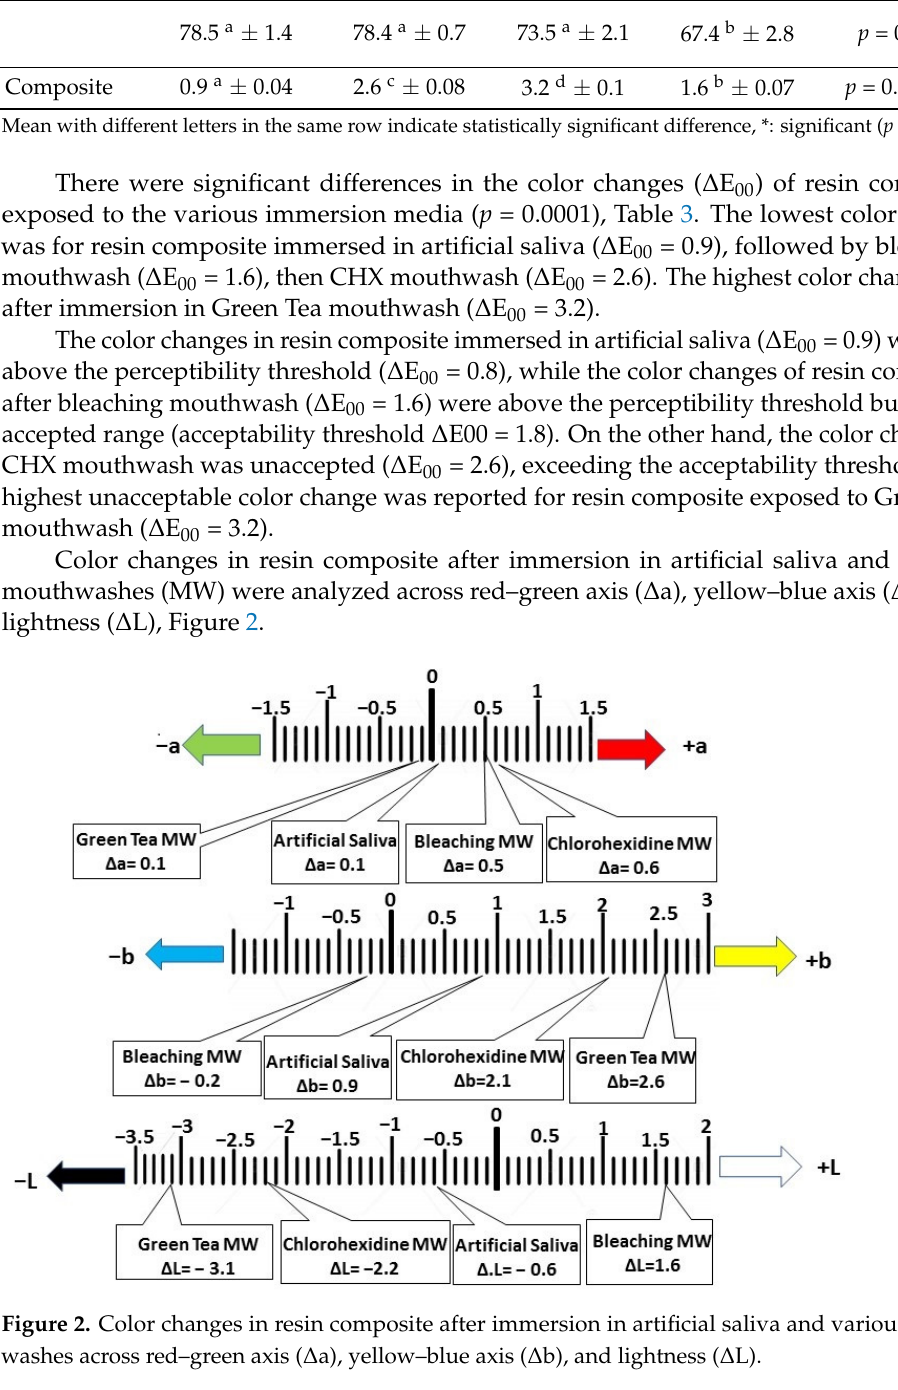
Table 3. The pH of artificial saliva and different mouthwashes.